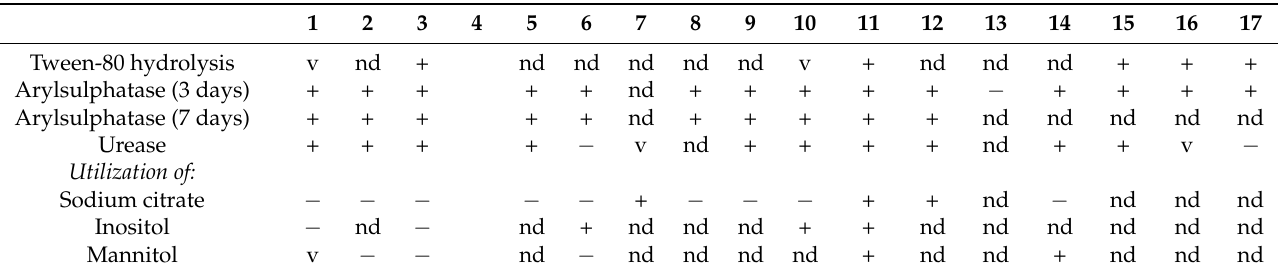
Table interpretation. 1: M. fortuitum subsp. fortuitum ; 2: M. fortuitum subsp. acetamidolyticum ; 3: M. alvei ; 4: M. boenickei ; 5: M. brisbanense ; 6: M.conceptionense ; 7: M.farcinogenes ; 8: M.houstonense : 9: M.neworleansense ; 10: M.peregrinum ; 11: M.porcinum ; 12: M.senegalense ; 13: M.septicum ; 14: M. setense ; 15: M. arceuilense ; 16: M. lutetiense ; 17: M. montmartrense ; +: positive; − : negative; v: variable outcome; nd: not